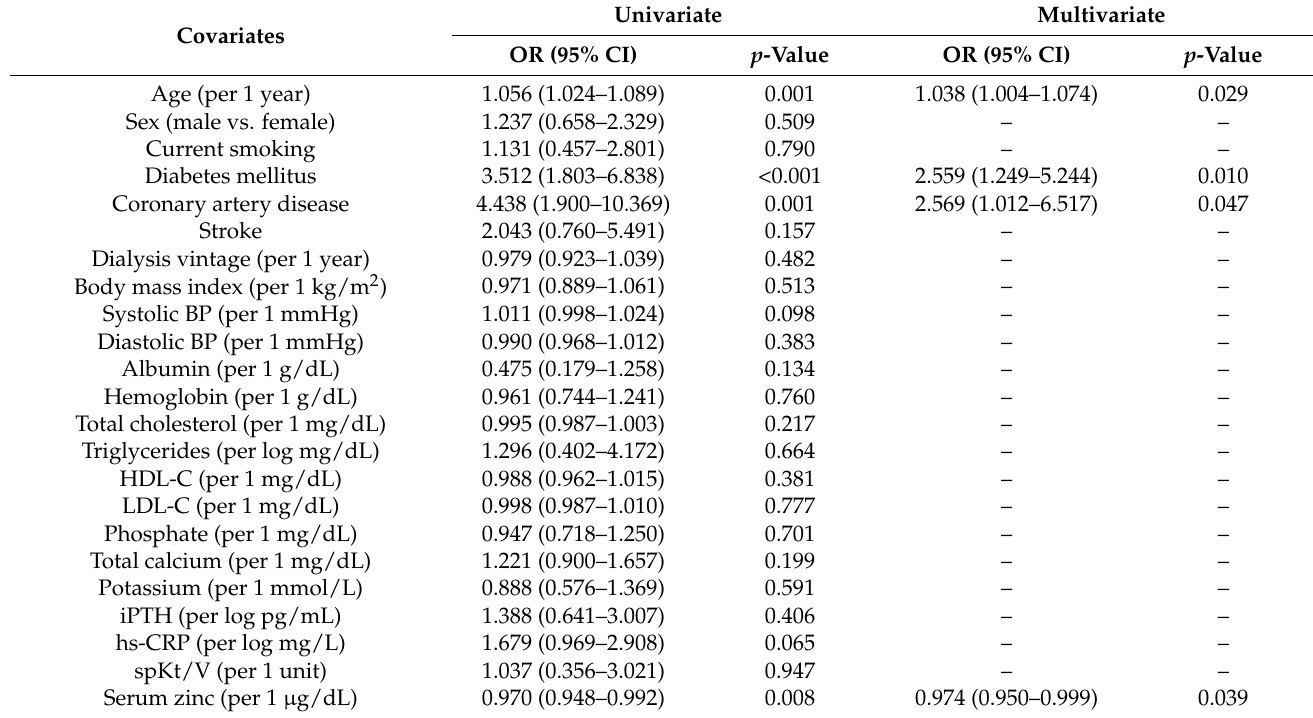
Table 3. Determinant factors of E/e’ ratio > 15 using univariate and multivariate logistic regression. Covariates